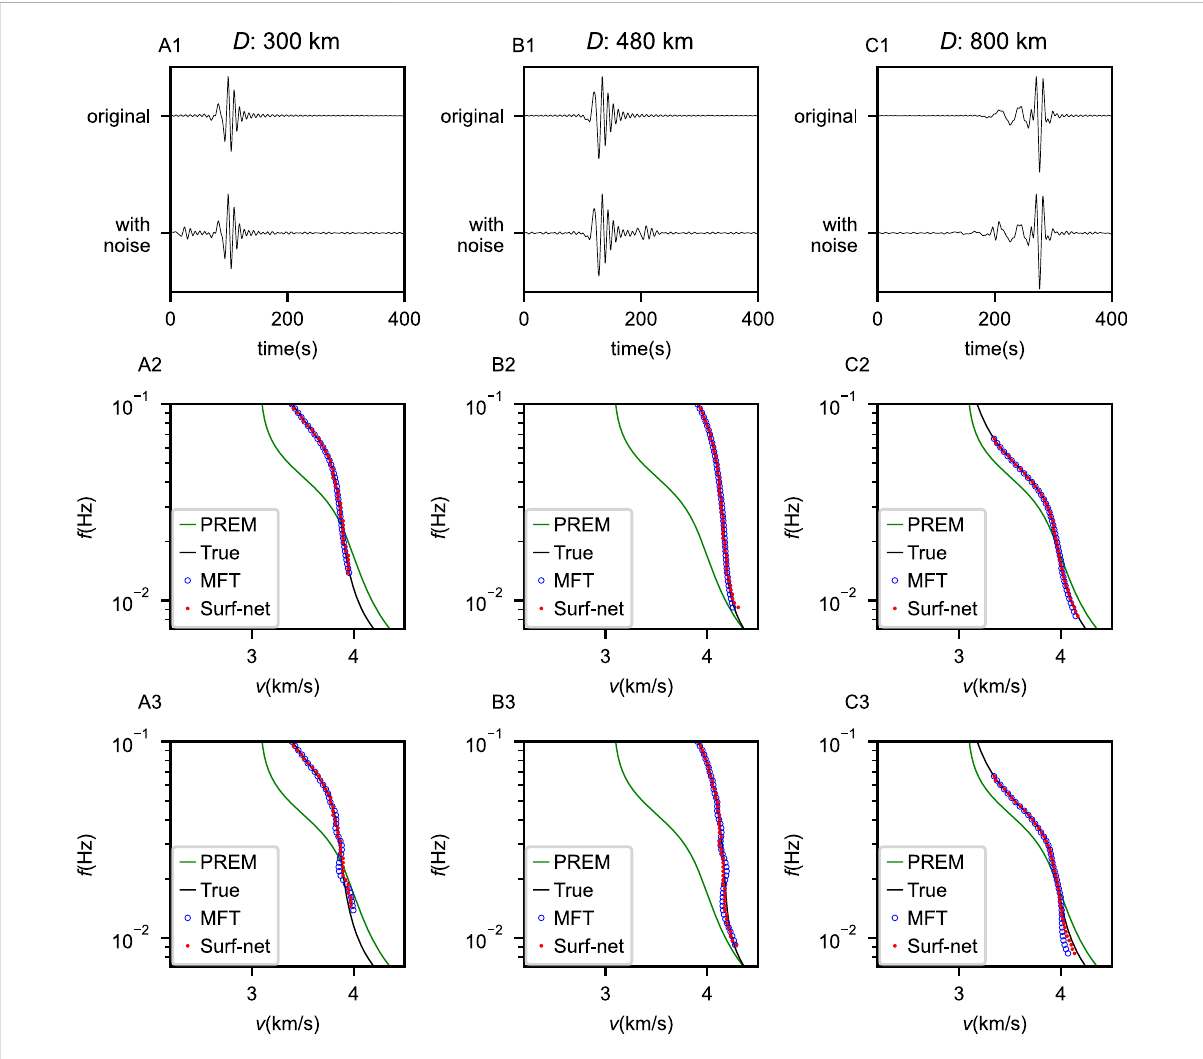
FIGURE 9 Three examples of synthetic data and extractions from them. In each example (A1-3 – C1-3) , the fi rst trace in the top plot (A1 – C1) is an original synthetic cross-correlation waveform corresponding to a chosen dispersion curve shown by black lines in the mid ( A2 – C2) and bottom plots (A3 – C3) while the second trace marked in the top plot (A1 – C1) is generated by adding noise before or after the primary wavelet to the original waveform. The picking results from the MFT and Surf-Net on the original and noised waveforms are shown in the mid (A2 – C2) and bottom (A3 – C3) plots,